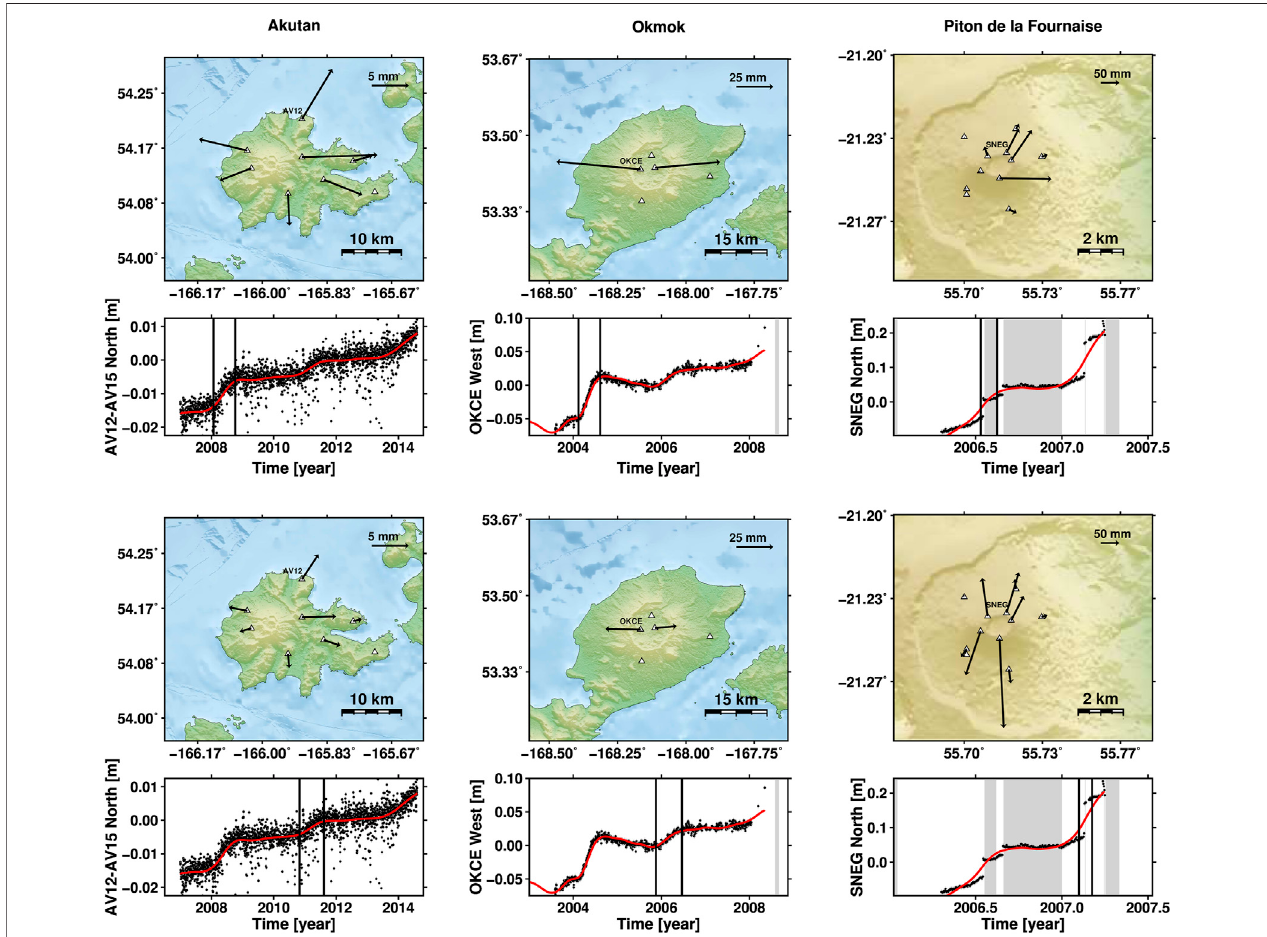
FIGURE 4 | Spatial and temporal pattern of horizontal displacements at the three volcanoes. The two maps for each volcano show the total horizontal displacements (black arrows) during a selected episode of in fl ation; these episodes are indicated by the two vertical black lines on the time series corresponding to the map.ThepanelswiththeselectedGPStimeseriesdisplayblackdotsfortherawGPSdatapointsandaheavyredlineforthesumofthecorrespondingM-SSAnonlinear volcanic signal reconstruction and linear trend. The GPS receivers associated with the plotted time series are labeled on the maps, as in Figure 2 .